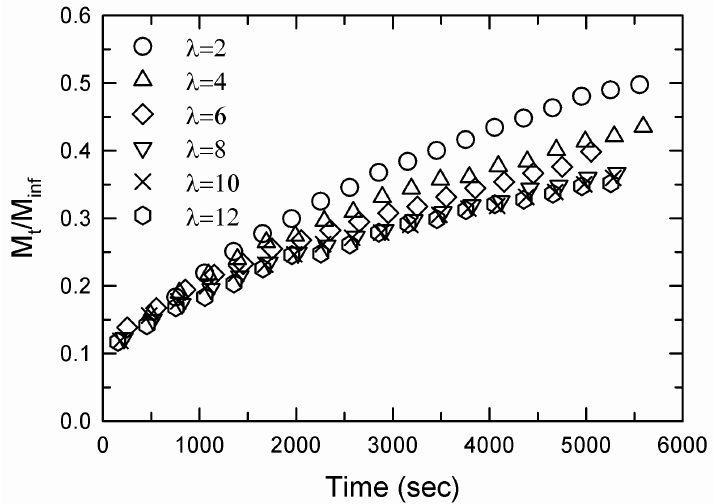
Figure 8. Water diffusion data for the AMPS(1,2,2,9)/AAm(2,0.1,0.01,97) DN hydrogel. The sample with λ = 2 exhibited Fickian diffusion, but for λ > 2 the diffusion became increasingly non-Fickian.